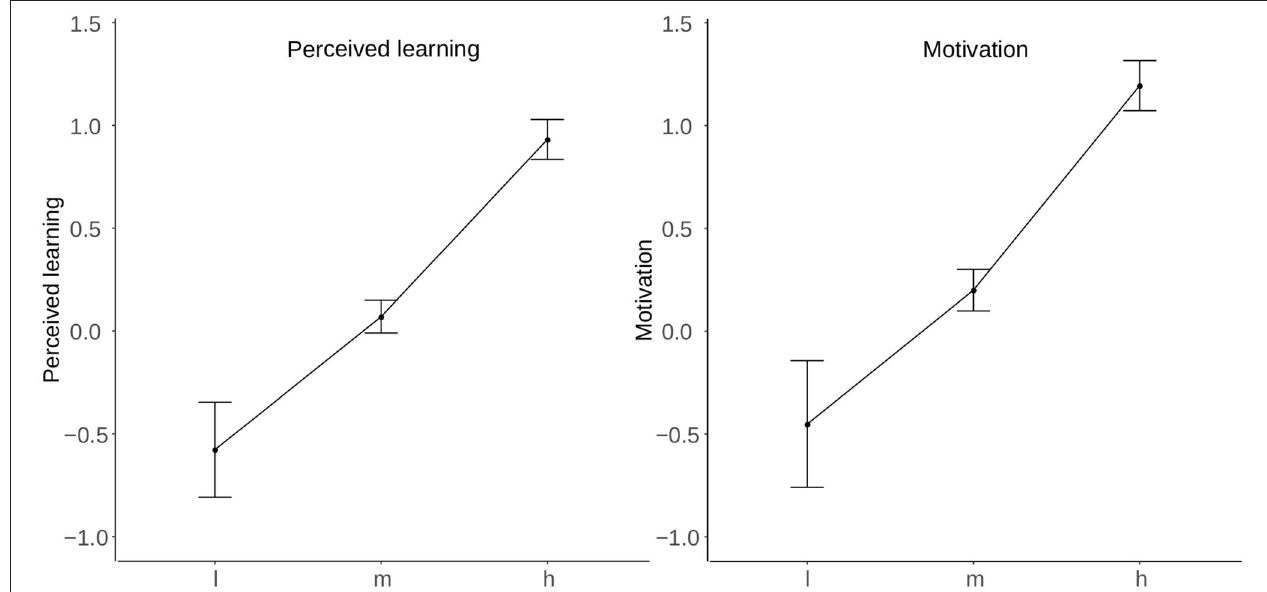
FIGURE 2 | Difference of means according to the intensity of the intervention (l, low intensity; m, medium intensity; h, high